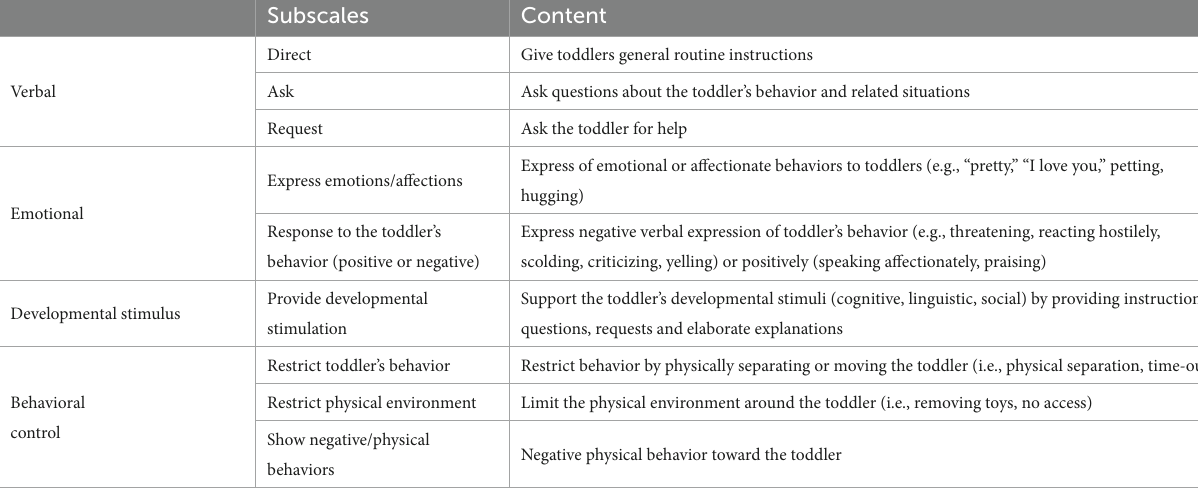
TABLE 3 The definitions of sensitivity of